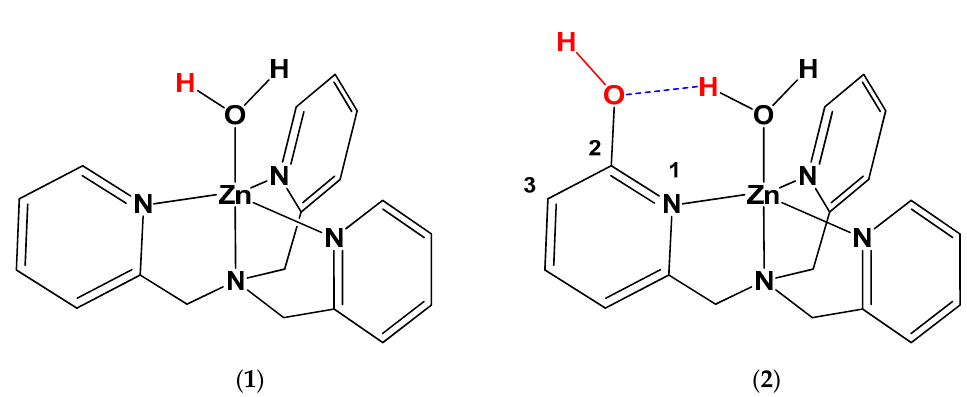
Figure 2. Structures of the two carbonic anhydrase (CA)-mimicking Zn catalysts, namely: ( 1 ) (tris(2-pyridylmethyl)amine)Zn(OH 2 ) complex and ( 2 ) (6-((bis(pyridin-2-ylmethyl)amino)methyl)pyridin-2-ol)Zn(OH 2 ) complex.